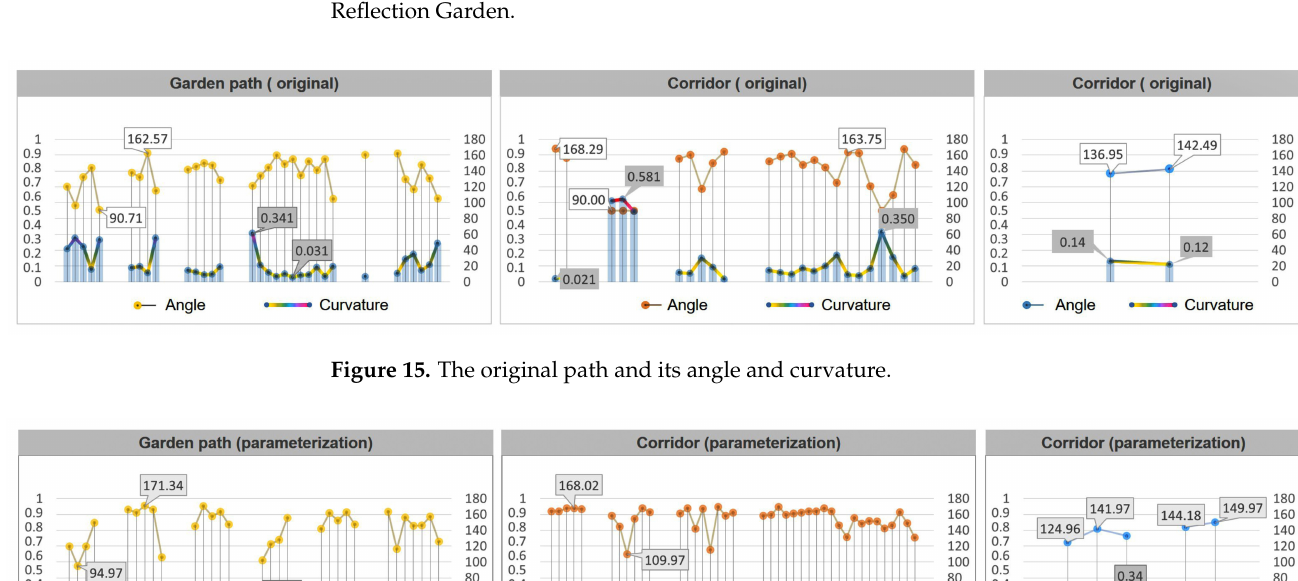
Figure 14. Comparison of original road and parametrically generated road in the Retreat and Reflection Garden.